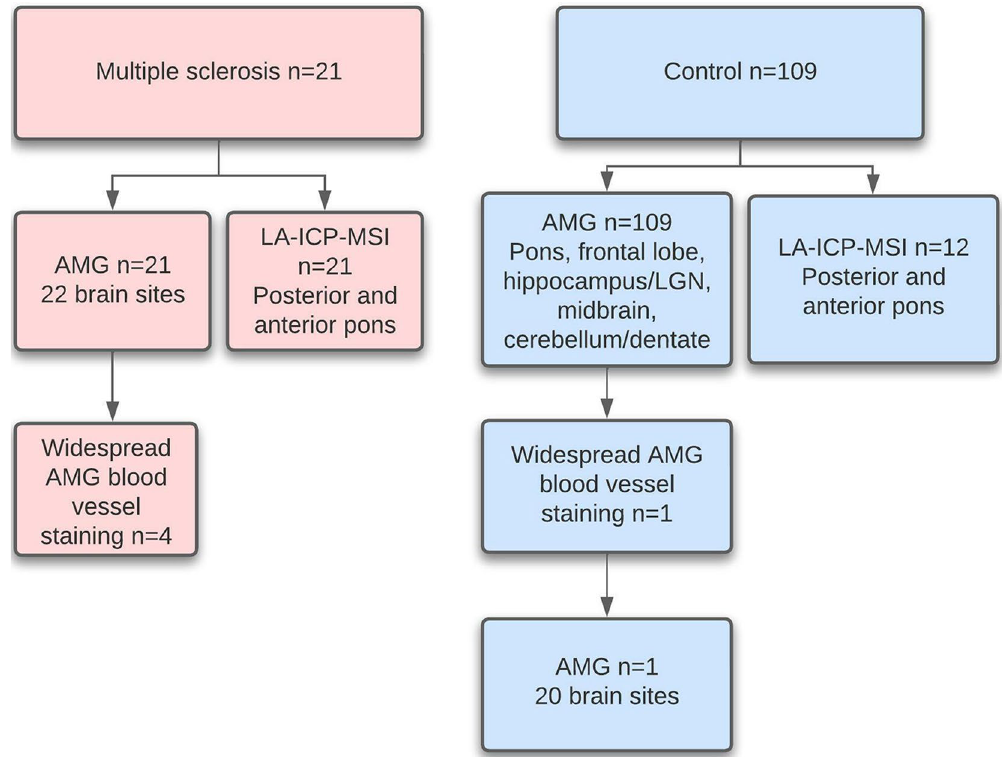
Figure 2. Sample collection and analysis. Twenty-one people with MS had autometallography (AMG) staining on paraffin sections from 22 different brain sites (including the pons). Four of these had widespread blood vessel AMG staining. All MS patients had laser ablation-inductively coupled plasma-mass spectrometry imaging (LA-ICP-MSI) of the posterior and anterior pons. The 109 non-MS controls had screening AMG of five brain regions. Only one of these had widespread AMG blood vessel staining, so this control had AMG performed on 20 different brain sites. Twelve controls had LA-ICP-MSI of the posterior and anterior